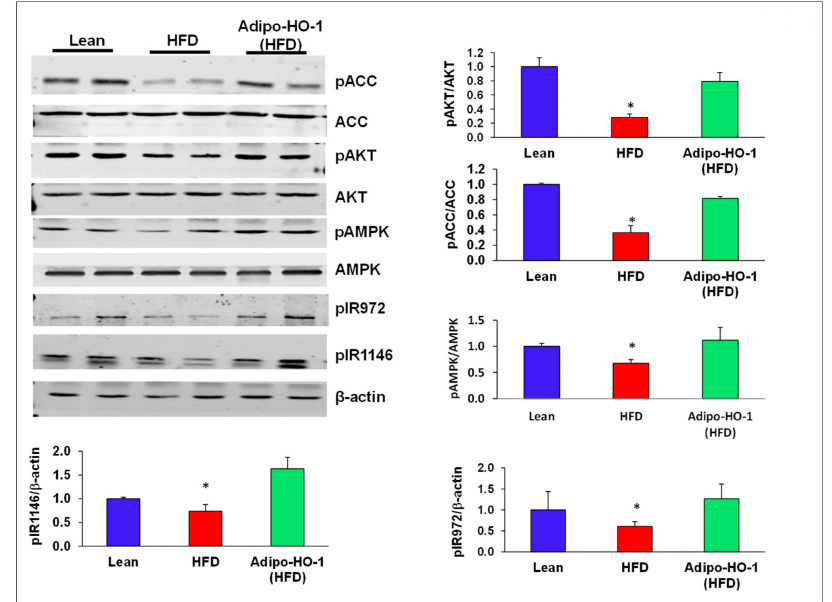
Representative Western blot analysis of insulin receptor phosphorylation and key phosphorylated proteins within the insulin receptor signaling cascade in adipose tissue of lean, HFD, and Lnv-adipo-HO-1 (HFD) mice. Representative Western blots and fluorometric analysis relative to β -actin of pACC, ACC, pAKT, AKT, pAMPK, AMPK, pIR972, and pIR1146; n = 5, * p < 0.05 versus lean and Lnv-adipo-HO-1 (HFD)